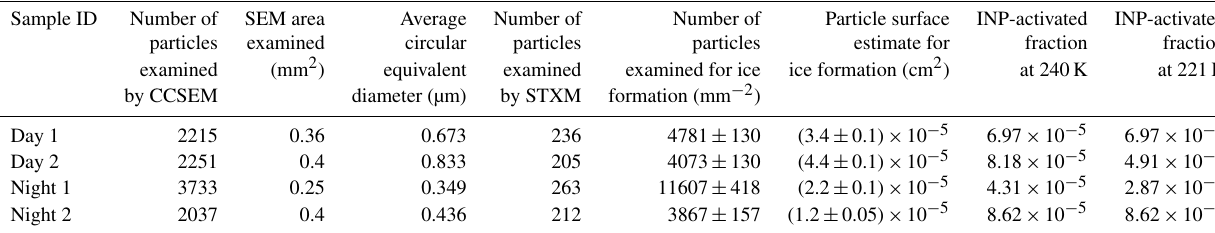
Table 2. Summary of particle sample information: sample name, number of particles examined by scanning electron microscopy (SEM), SEM sample surface area examined, SEM determined average circular equivalent diameter, number of particles examined by scanning transmission X-ray microscopy (STXM), number of particles examined for ice formation, particle surface area involved in ice formation experiments, and INP-activated